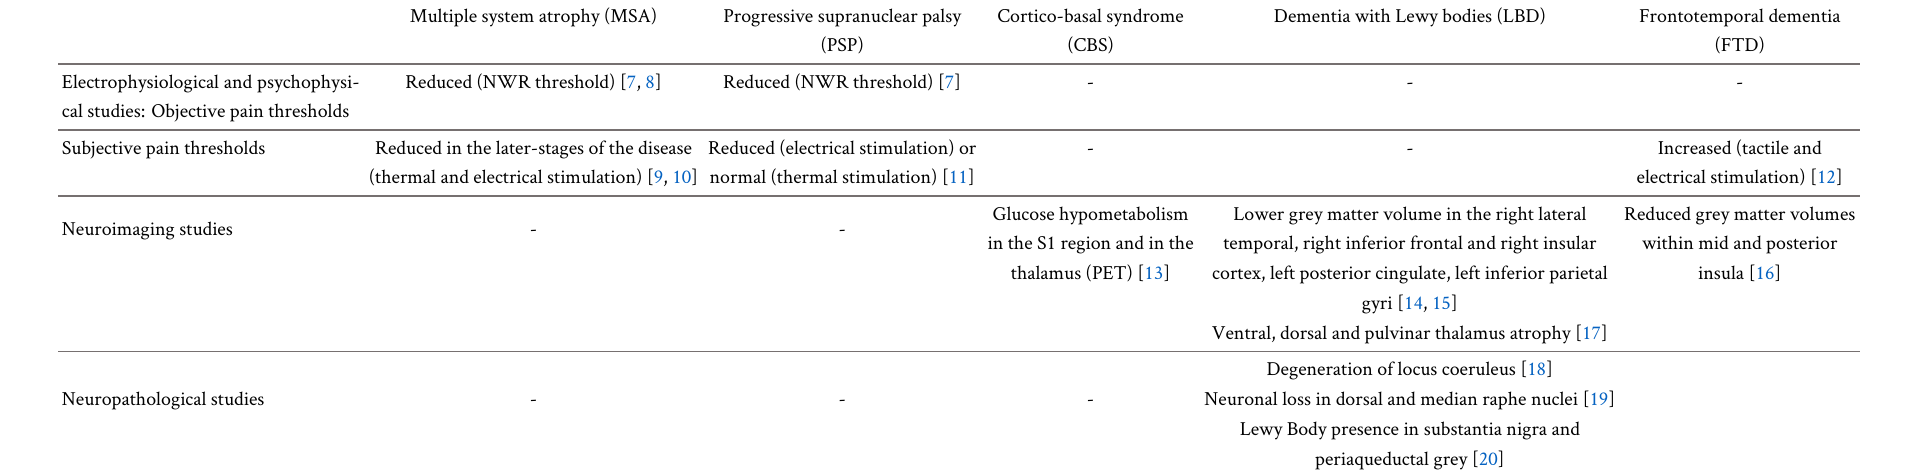
Table 1. Summary of findings from pain-related electrophysiological, psychophysical, neuroimaging and neuropathological studies in multiple-system atrophy,